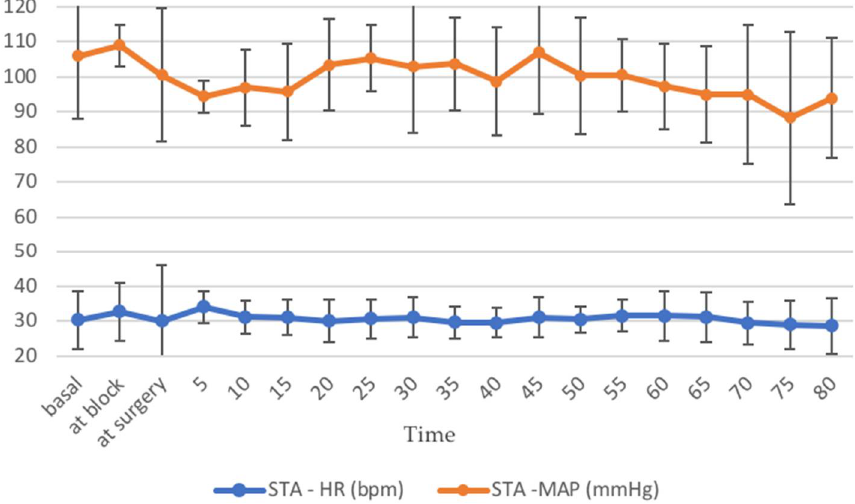
Figure 5. Heart rate (HR, beats/min) and mean arterial blood pressure (MAP, mmHg) recorded in horses included in group STA (undergoing standing analgo-sedation, n = 6) during the procedure. Data are reported as mean value and bars represent the standard deviation.